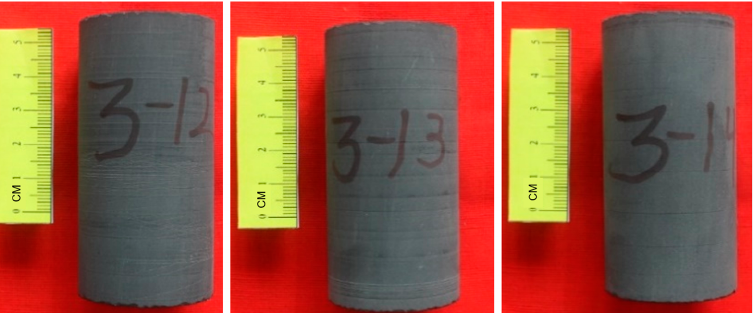
Figure 14. Shale cores of 50 mm in diameter and 100 mm in height collected from the same outcrop. Non ‐ English in figure indicate